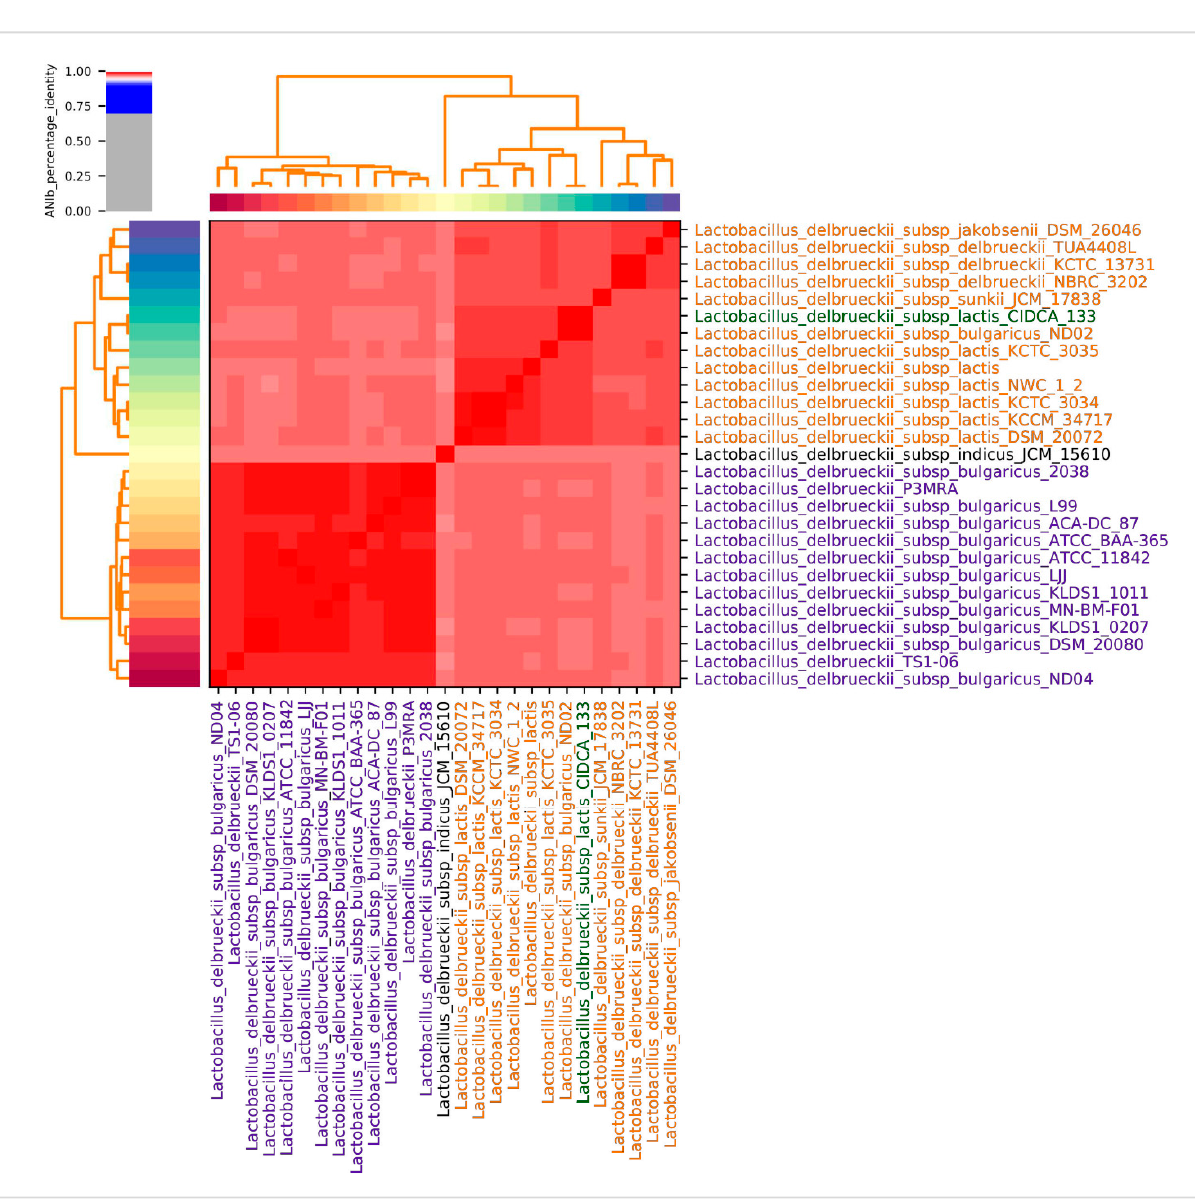
Figure 3. Heatmap representing the degree of similarity between Lactobacillus delbrueckii genomes based on the Average Nucleotide Identity (ANI). Red = more similar, light red = less similar.